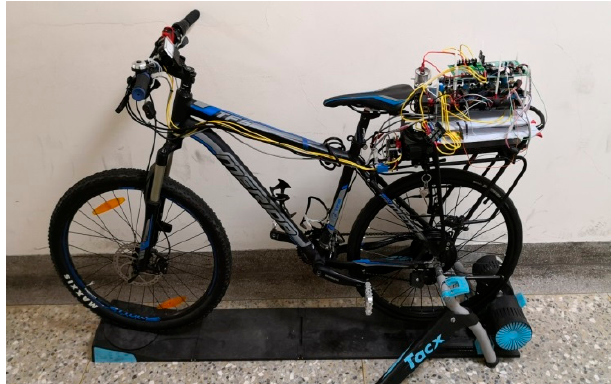
Figure 9. Experimental platform of electric bicycle.